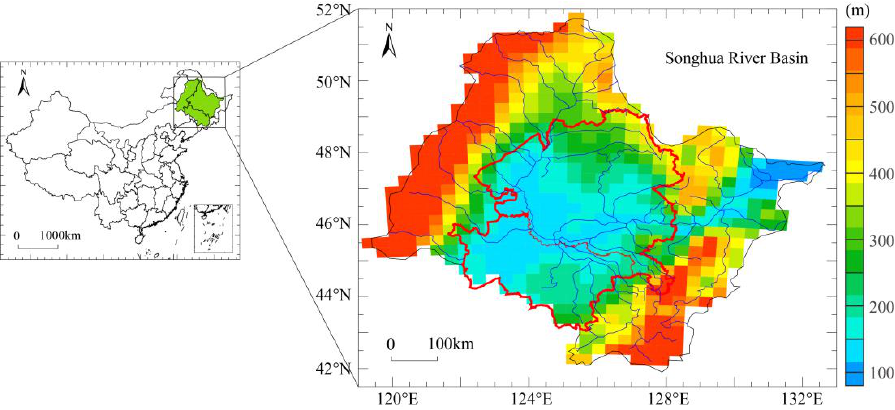
Figure 1. The Songnen Plain (red polygon) in the Songhua River Basin, Northeast China. The right figure is an elevation map of the basin.